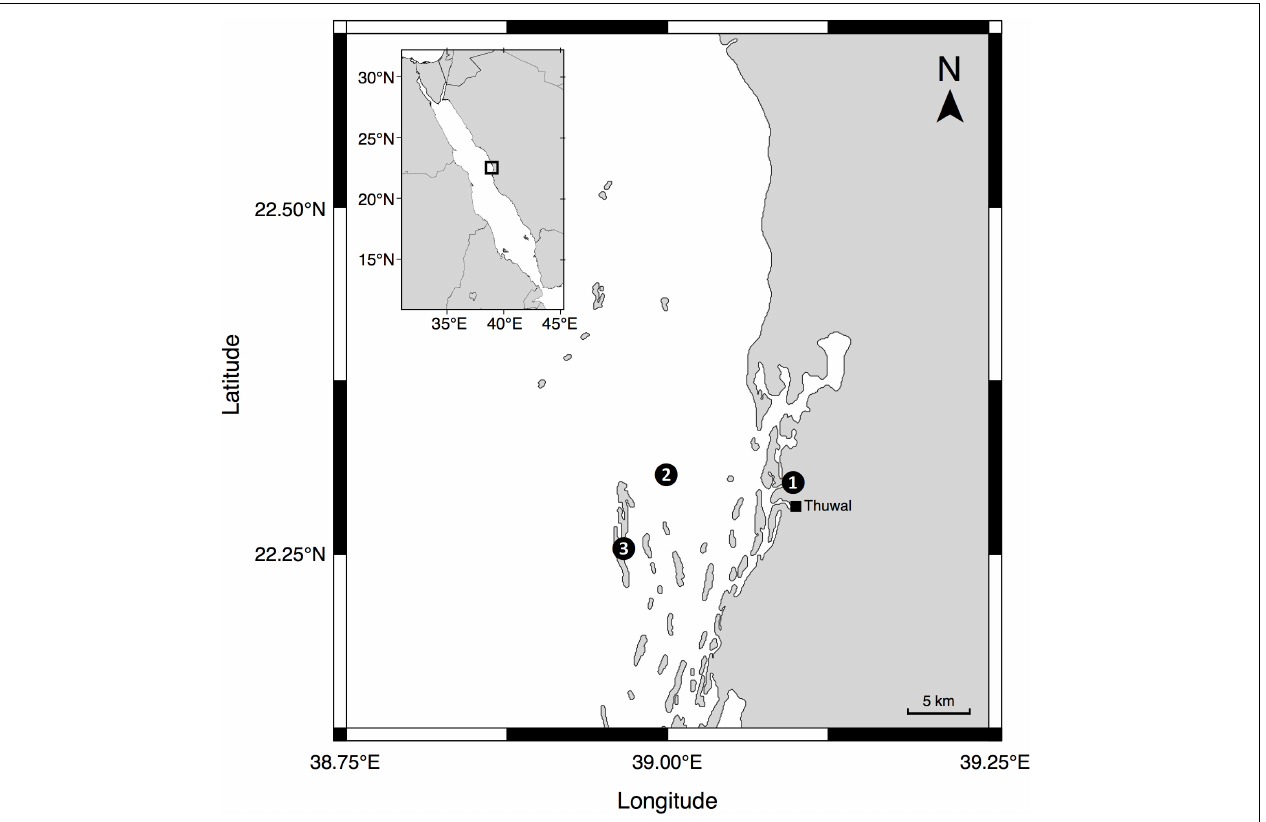
FIGURE 1 | Locations of the sampling sites where time series measurements were taken: (1) The pier of the Coastal and Marine Resources Core Lab (CMOR) at KAUST, (2) the pelagic station, and (3) Al Fahal